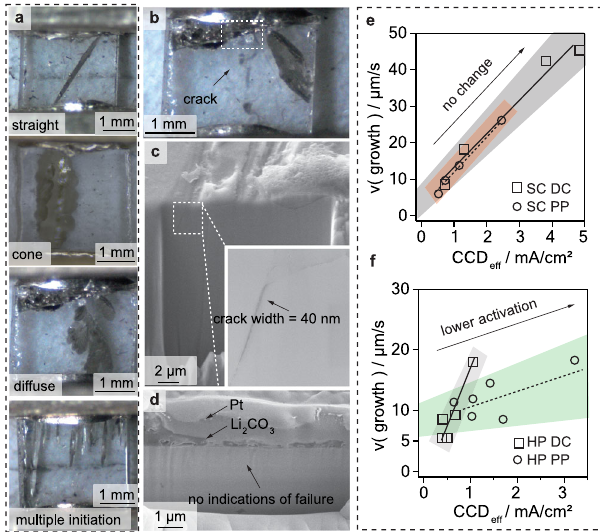
Fig. 3 | Microscopy investigations of the Li metal depositions. a Overview of differentLidendritesobservedduringopticaltrackingofsinglecrystallinesamples being of either straight, cone or diffuse, type. In some cases, multiple dendrite initiationwasspotted,wheredendritesstartedgrowingfromseveralinitiationsites at the same time. The dendrite growth can be seen in motion in Supplementary Videos 1 – 5. Crack analysisperformed on anSC ( b – d ) and HP ( f ), cut parallel to the formerly coated electrolyte surface with a focused ion beam. For the single crys- tallinesamplesmallsubsurfacecracksatawidthof40nmwerefound,whereasfor thehot-pressednocrackslargeenoughtoresolvewerefound.Growthratesplotted againsttheeffectivecriticalcurrentdensity(CCD eff )valuesincaseofdirectcurrent (DC) or pulsed current (PP) operation for single crystalline LLZTO (SC, e ) and hot- pressed polycrystalline LLZTO (HP, f ). The trends have been colored in gray (DC), orange (SC PP) and green (HP DC) for visualization